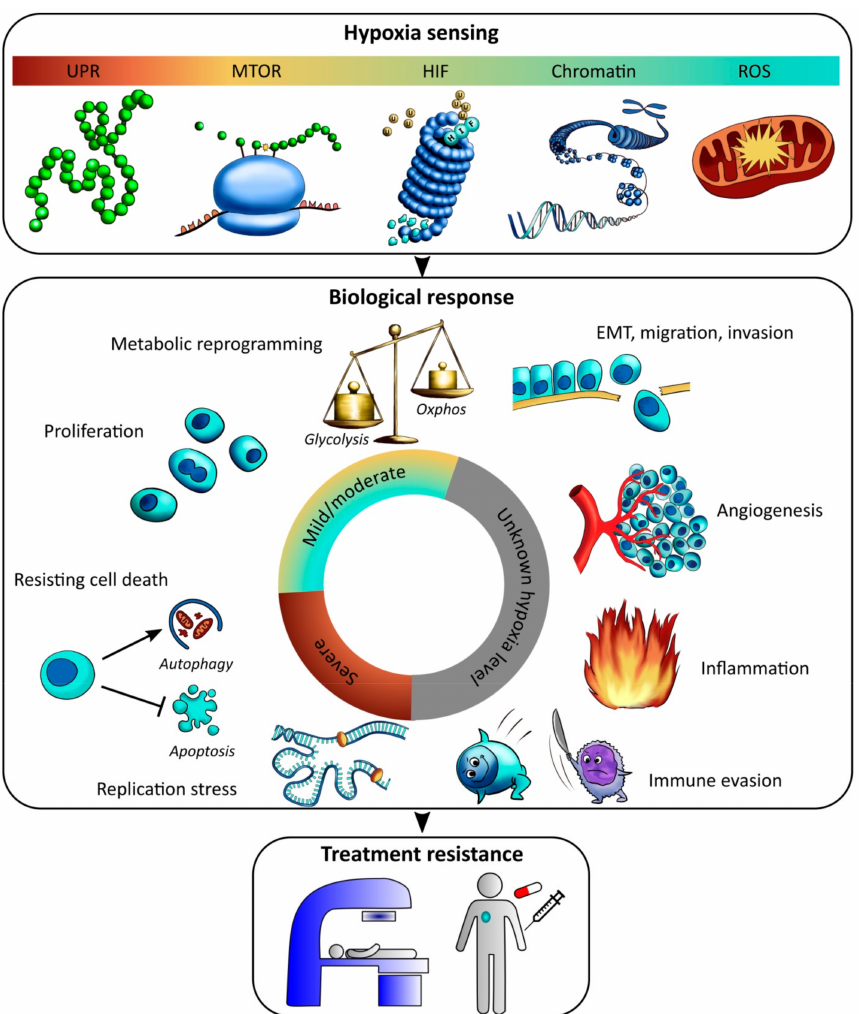
Figure 5. Hypoxia sensing and response. Illustration of hypoxia sensing mechanisms (upper), bio- logical responses (middle) in relation to hypoxia level from mild to severe, and subsequent treatment resistance (lower). HIF, Hypoxia-inducible factor; UPR, unfolded protein response; MTOR, mam- malian target of rapamycin; ROS, reactive oxygen species; EMT, epithelial-mesenchymal transition. Hypoxia levels are indicated by the color code, with approximate oxygen concentrations (% O 2 ) and tensions (mmHg) provided by the x -axis in Figure 1C. Unknown hypoxia level is indicated in